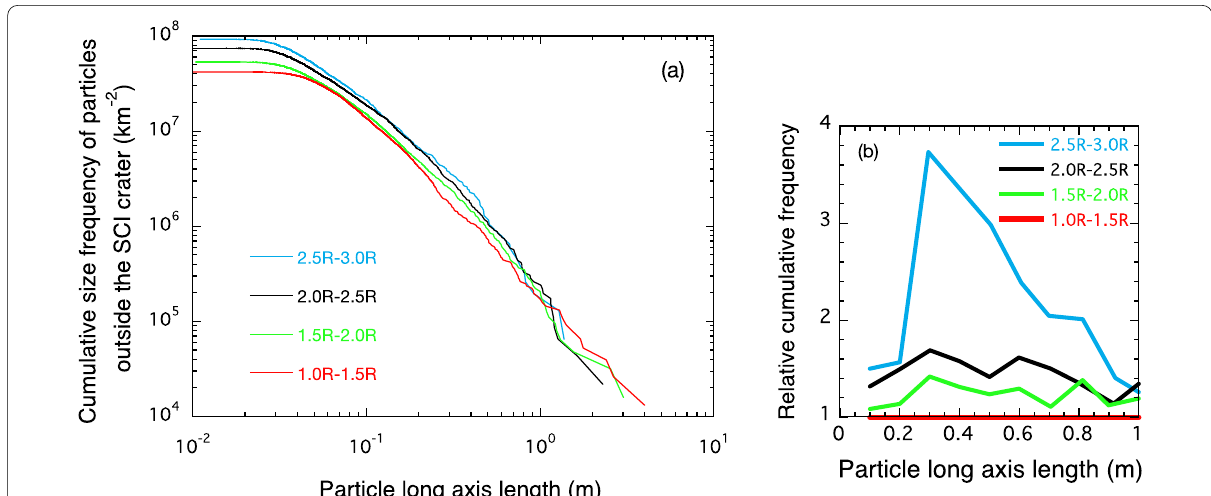
Fig. 2 a Radial variation of cumulative size–frequency distributions of particles located within the annulus of 1.0R–1.5R, 1.5R–2.0R, 2.0R–2.5R, and 2.5R–3.0R. b Each cumulative frequency in a is divided by the cumulative frequency of particles within the innermost annulus of 1.0R–1.5R every 0.1